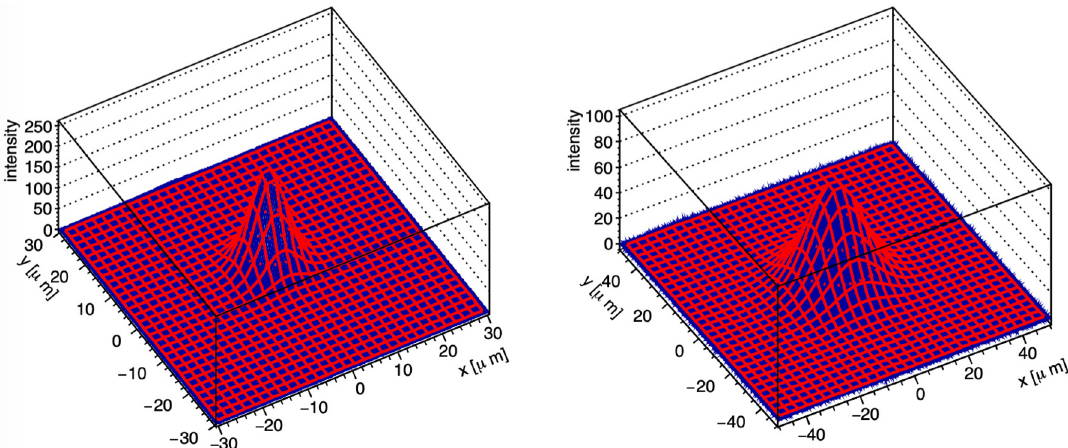
Figure 10 . Fitting of focal-plane intensity profiles with two-dimensional Gaussian distributions constrained by x – y symmetry for creation (left) and inducing (right)